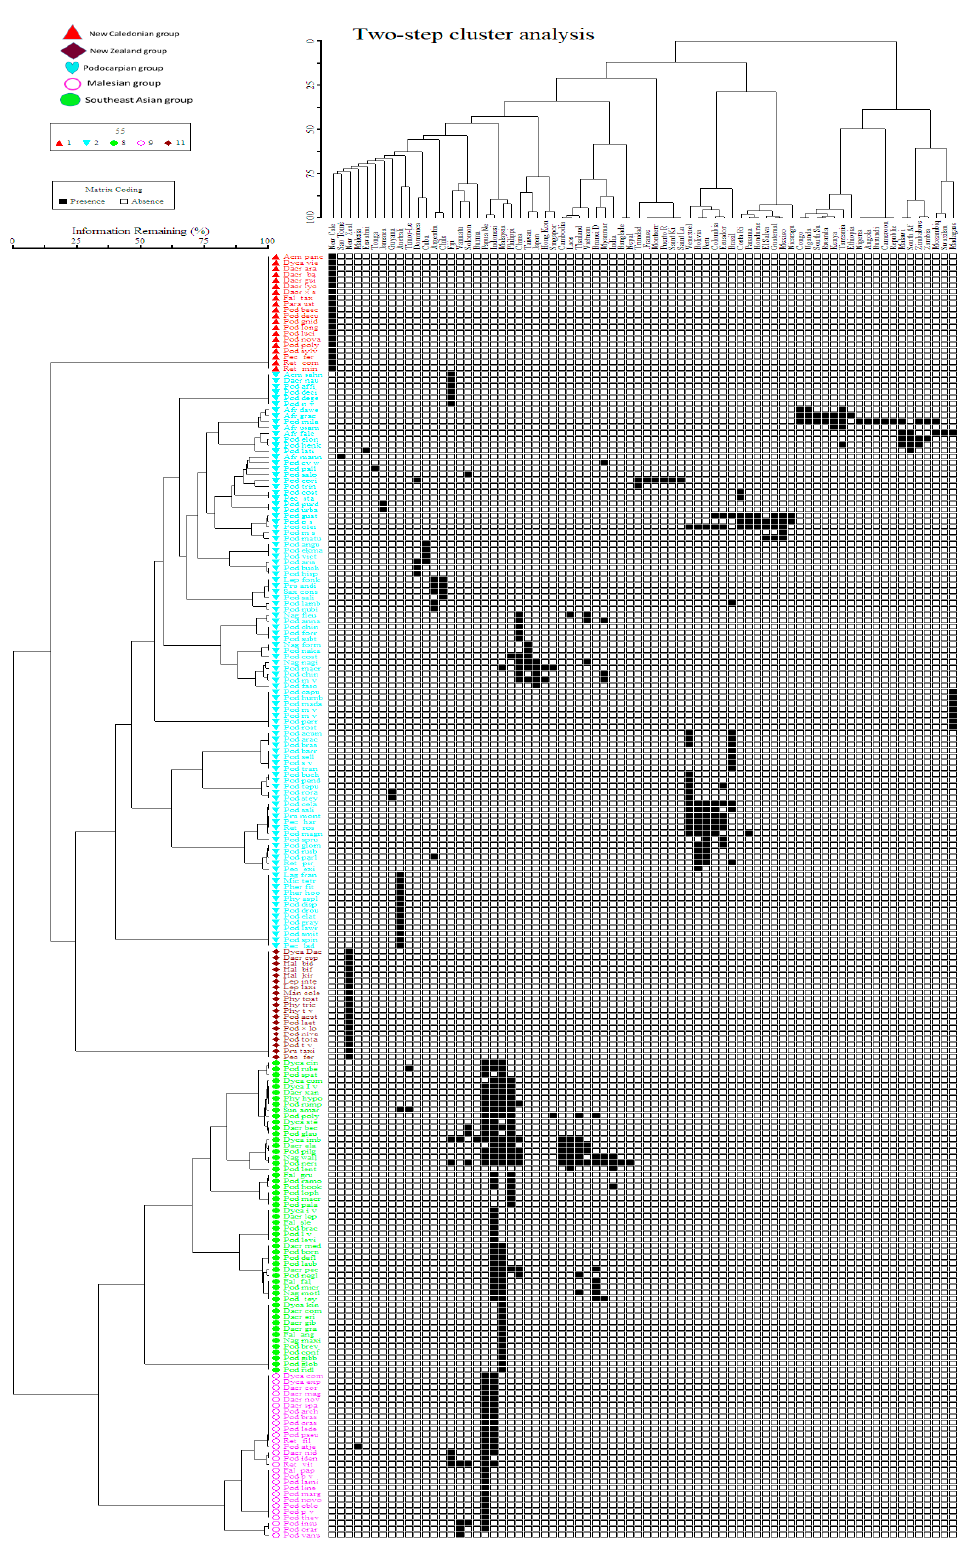
Figure 2. Diagram of two-way cluster analysis. The vertical matrix axis consists of more than 200 podocarp species coded by scientific name and the horizontal axis is the distributed countries (74 countries). The matrix was constructed depending on the presence (black) and absence (white). The species were grouped into five main clusters, I. New Caledonian group, II. New Zealand group and III. Malesian group, IV. Southeast Asian group and V. Podocarpian group.